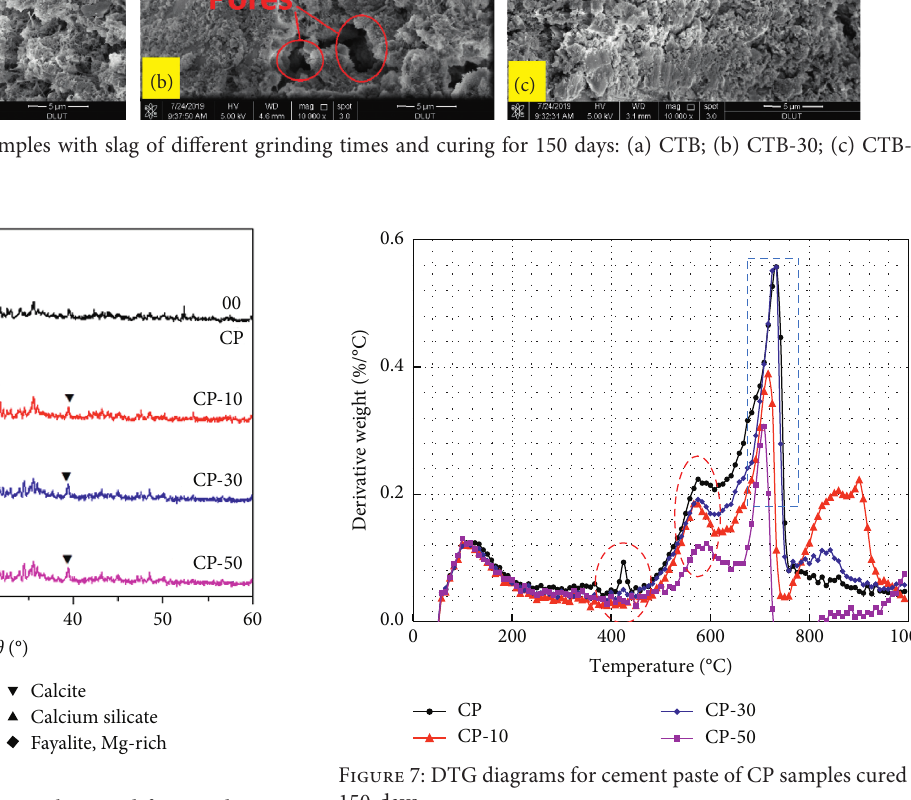
Figure 6: XRD results for CP samples cured for 150 days.